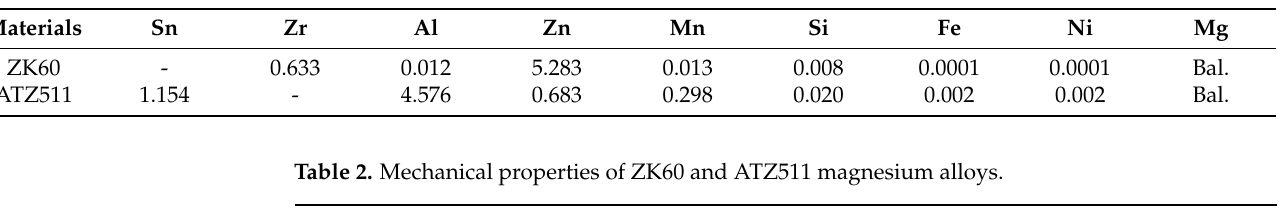
Table 1. Chemical compositions of ZK60 and ATZ511 magnesium alloys (wt.%).